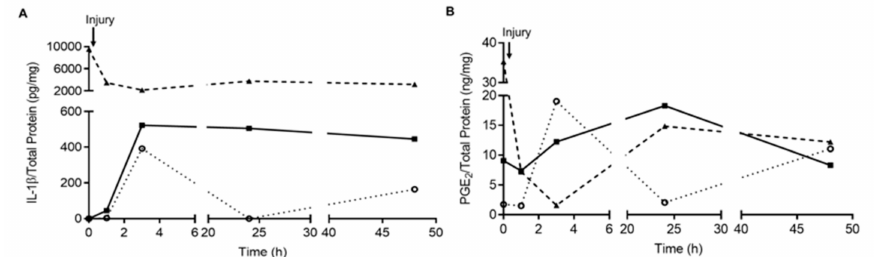
Figure A2. Systemic inflammatory profile of animals with punctured IVD over a 50-h period. Blood plasma samples were collected from the lateral tail vein before injury and 1-, 3-, 24-, 48- and 50-h post-lesion to trace a systemic inflammatory profile upon injury. A ) Kinetics of interleukin (IL)-1 β (pg / mg protein) and B ) Prostaglandin E2 (PGE2, ng / mg protein) levels in the plasma, n =